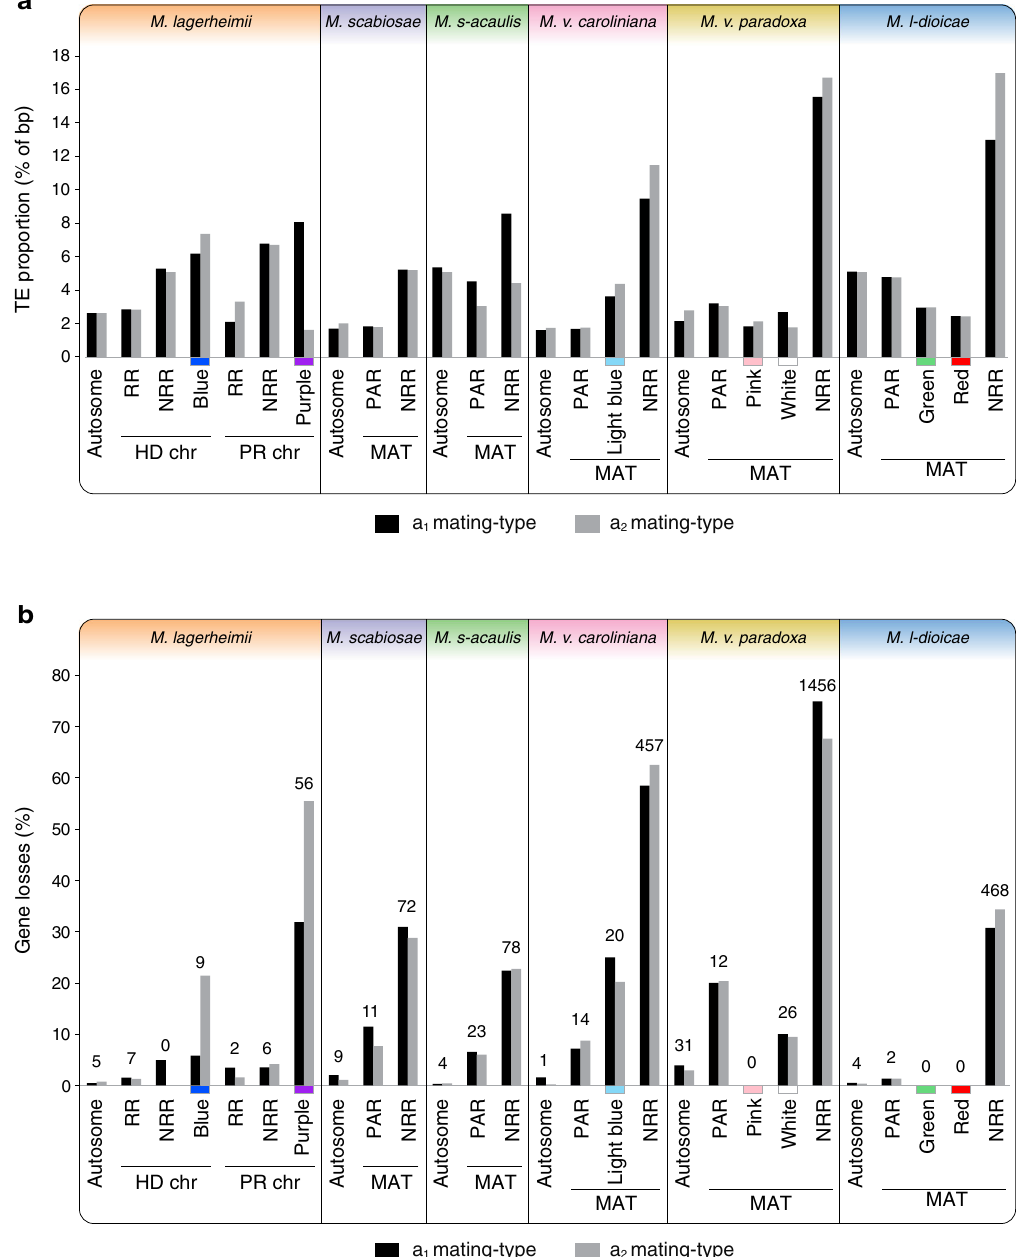
Fig. 5 Differential degeneration across strata and species. We quanti fi ed the TE content and gene loss in genomes of both mating types (a 1 and a 2 ) of all species under study. For each species, we measured the TE accumulation separately for one fully assembled autosome (as a control), recombining regions (RR), and non-recombining regions (NRR) on mating-type chromosomes (MAT), separating the youngest evolutionary strata (light blue, red, green pink, and white strata) from the remaining of the NRR where applicable. Strata were ordered from the youngest to the oldest per species. In M. lagerheimii , the NRRs correspond to the regions between the mating-type loci and the putative centromeres, while in the other species they mostly correspond to the regions ancestrally between the HD and PR loci. The purple and blue strata were too rearranged within the large non-recombining region to quantify their speci fi c gene loss or TE content except in M. lagerheimii . a Transposable element (TE) content (percent of base pairs); b Gene loss (genes with an allele present in the genome of one mating type but absent from the genome of the opposite mating type). Numbers at the top of the bars indicate the numbers of genes missing in the a 2 mating-type chromosome, present only in the a 1 mating-type